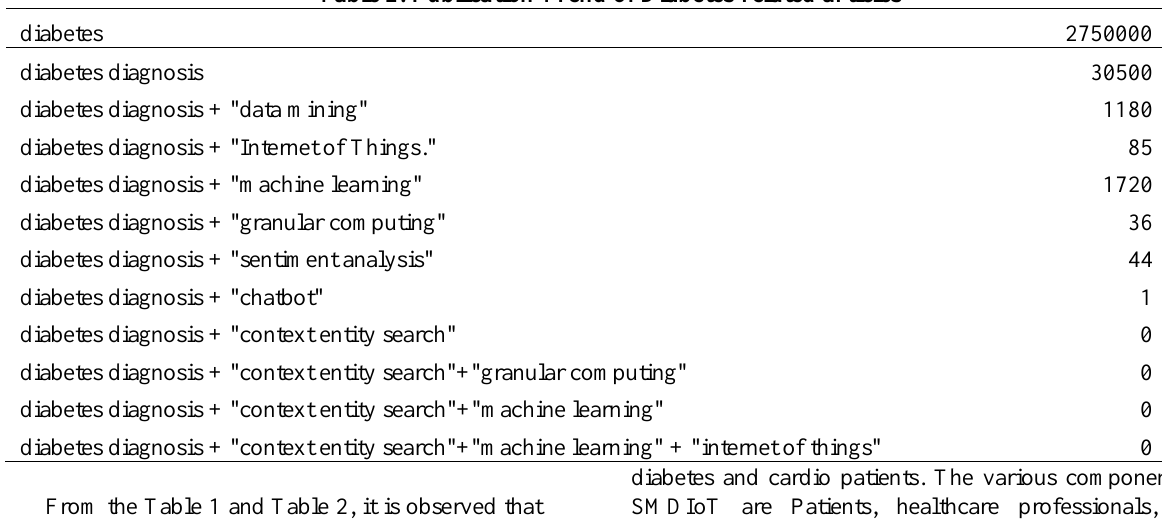
Table 2: Publication Trend of Diabetes-related articles